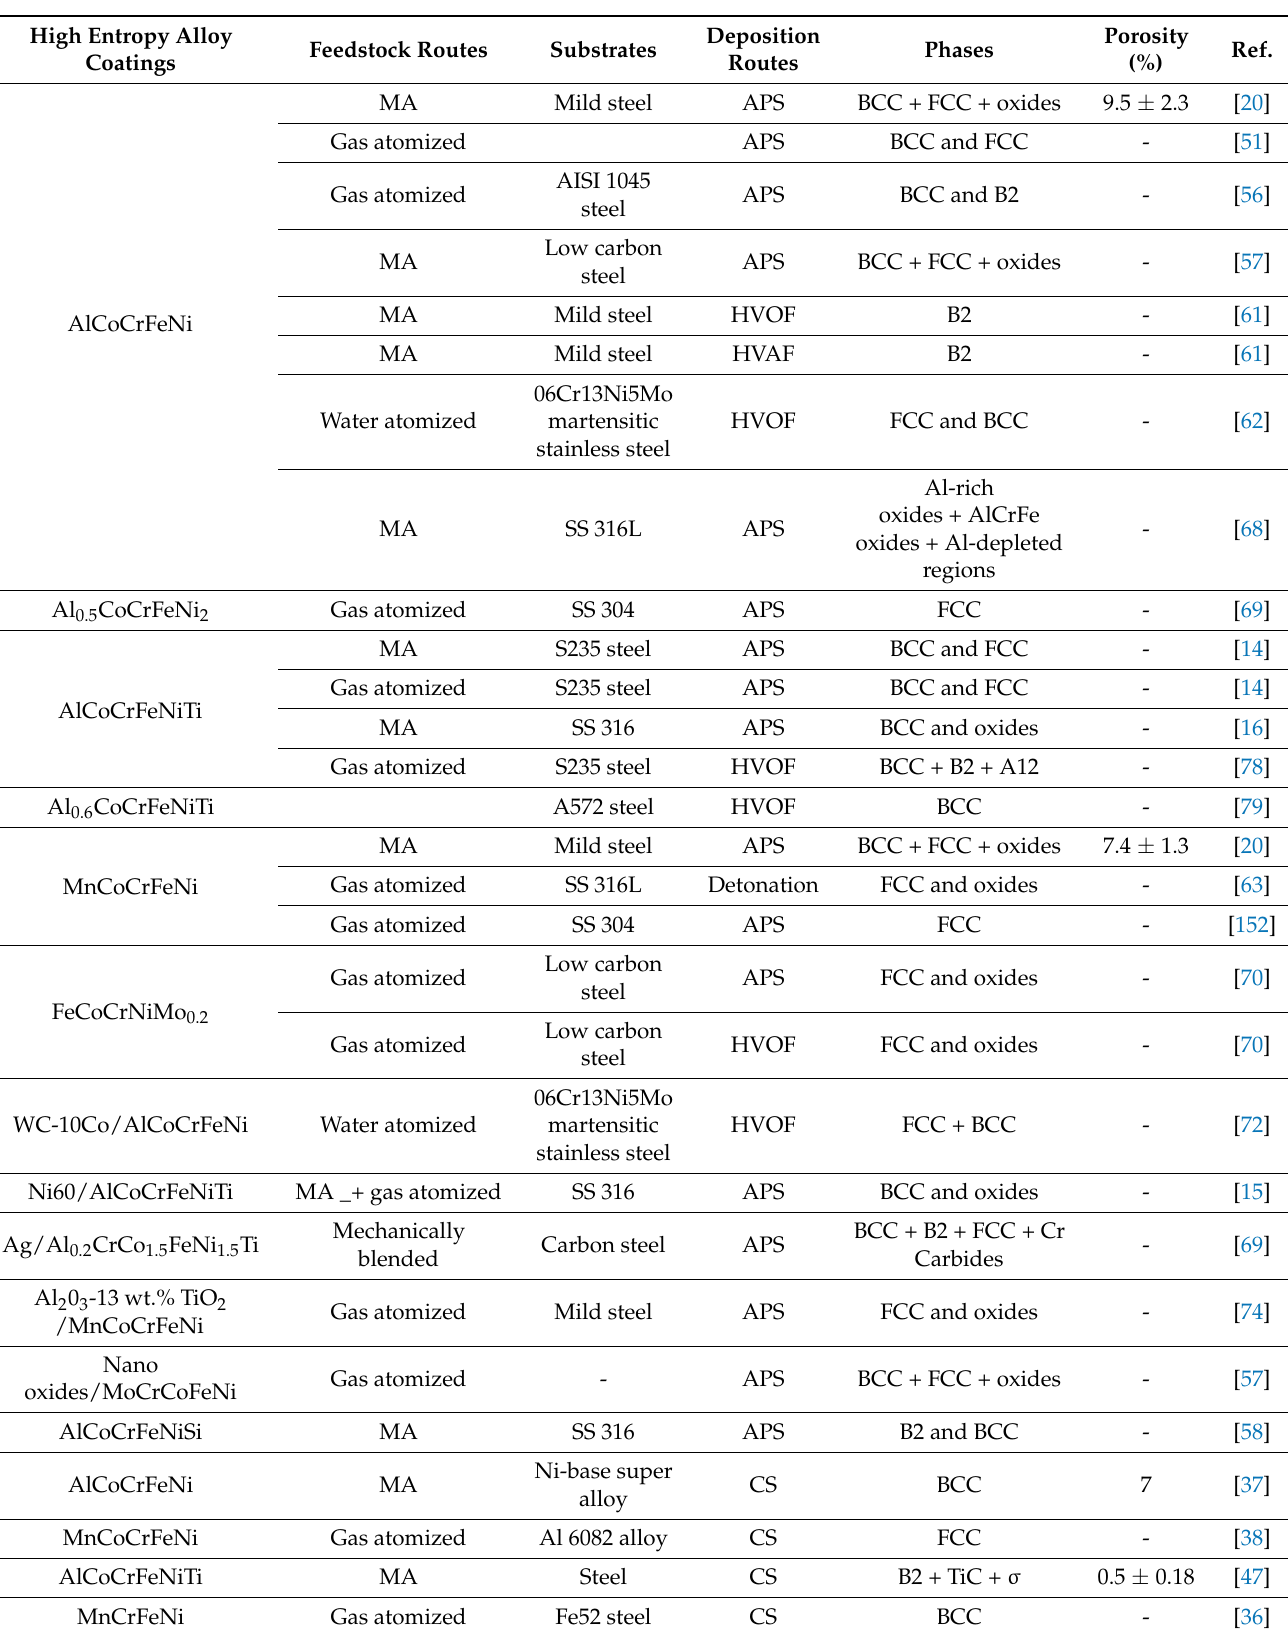
Table 3. Different high-entropy alloy compositions and their phase formations and porosity levels according to deposition